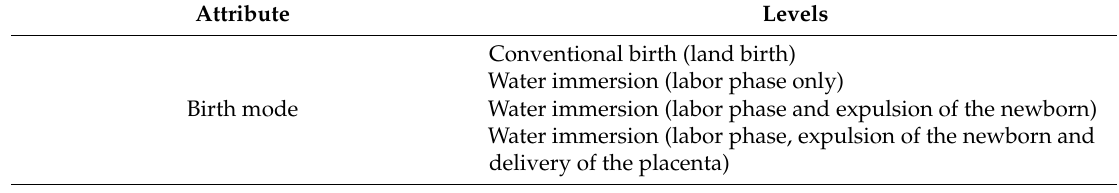
Table 3. Attributes and levels for the discrete choice experiment